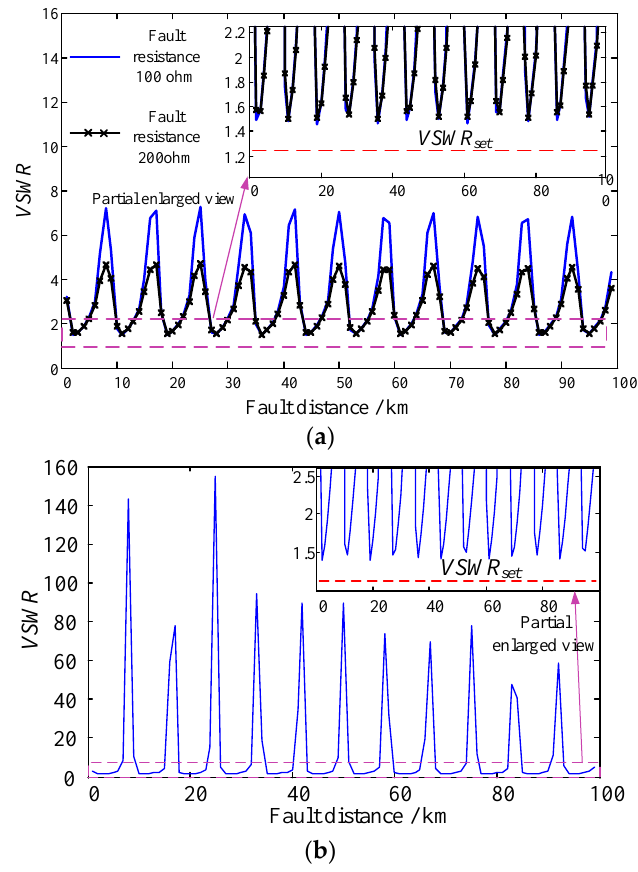
Figure 10. The VSWR for different fault position of single-line earth fault with matched terminal resistor. ( a ) the transition resistance are 100 Ω and 200 Ω, respectively; ( b ) the transition resistance is 0.1 Ω.